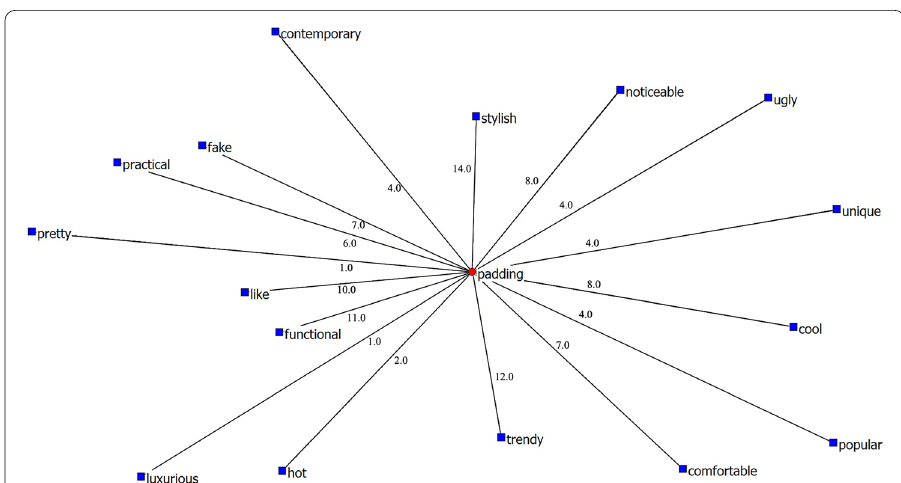
Fig. 4 The ego network of “padding” (2018 fall/winter season). The numbers on the lines indicate the strength of the links in terms of co-occurrences with sentiment words